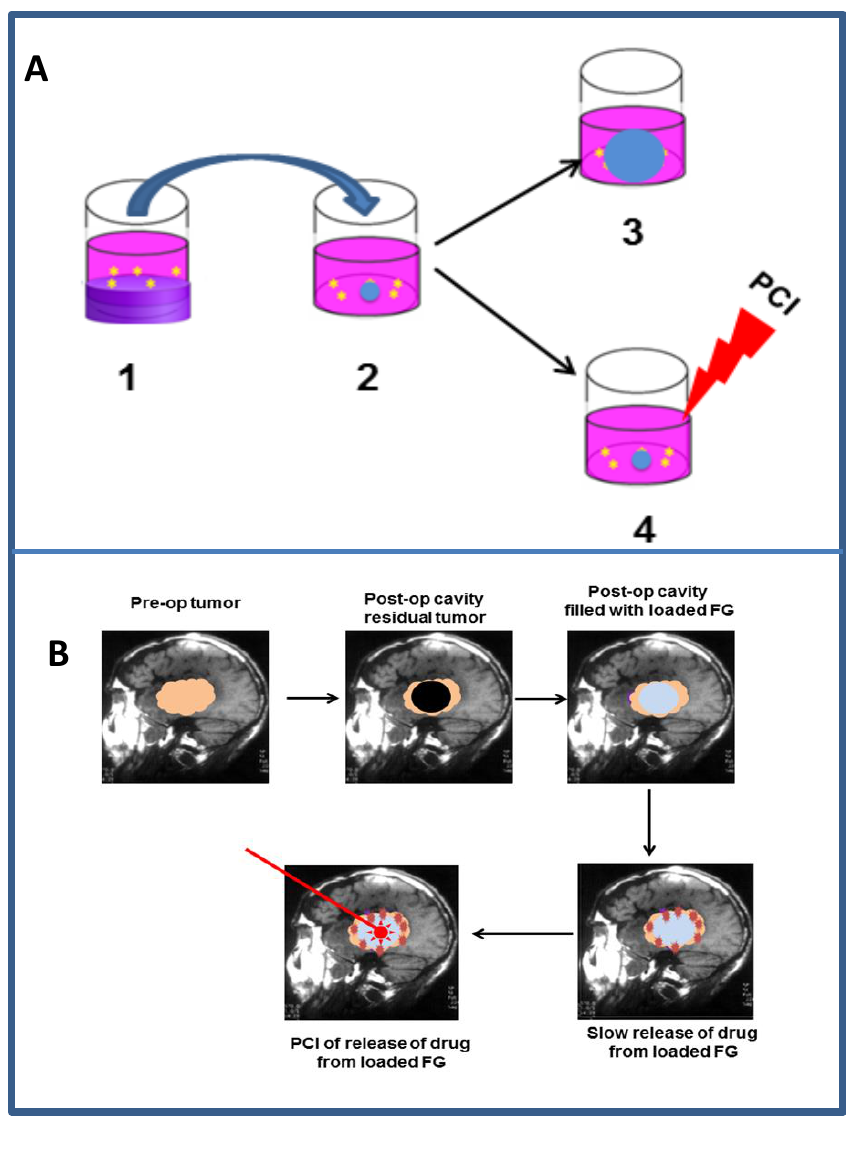
Figure 9. ( A ) Drug release from fibrin glue. (1) Fibrin glue (FG) layers formed with incorporated drug overlaid with culture medium. (2) Supernatant harvested at different times from drug containing FG layers co-cultured with spheroids formed from glioma cells pre cultured with photosensitizer in the (3) absence or (4) presence of light treatment (PCI). Spheroid growth was monitored for 14 days. ( B ) Proposed clinical translation of FG-PCI protocol. Following tumor resection, the resection cavity is filled with drug / photosensitizer loaded FG. The FG slowly dissolves releasing the drug. Light treatment done through a temporarily surgically placed optical fiber positioned in the center of FG